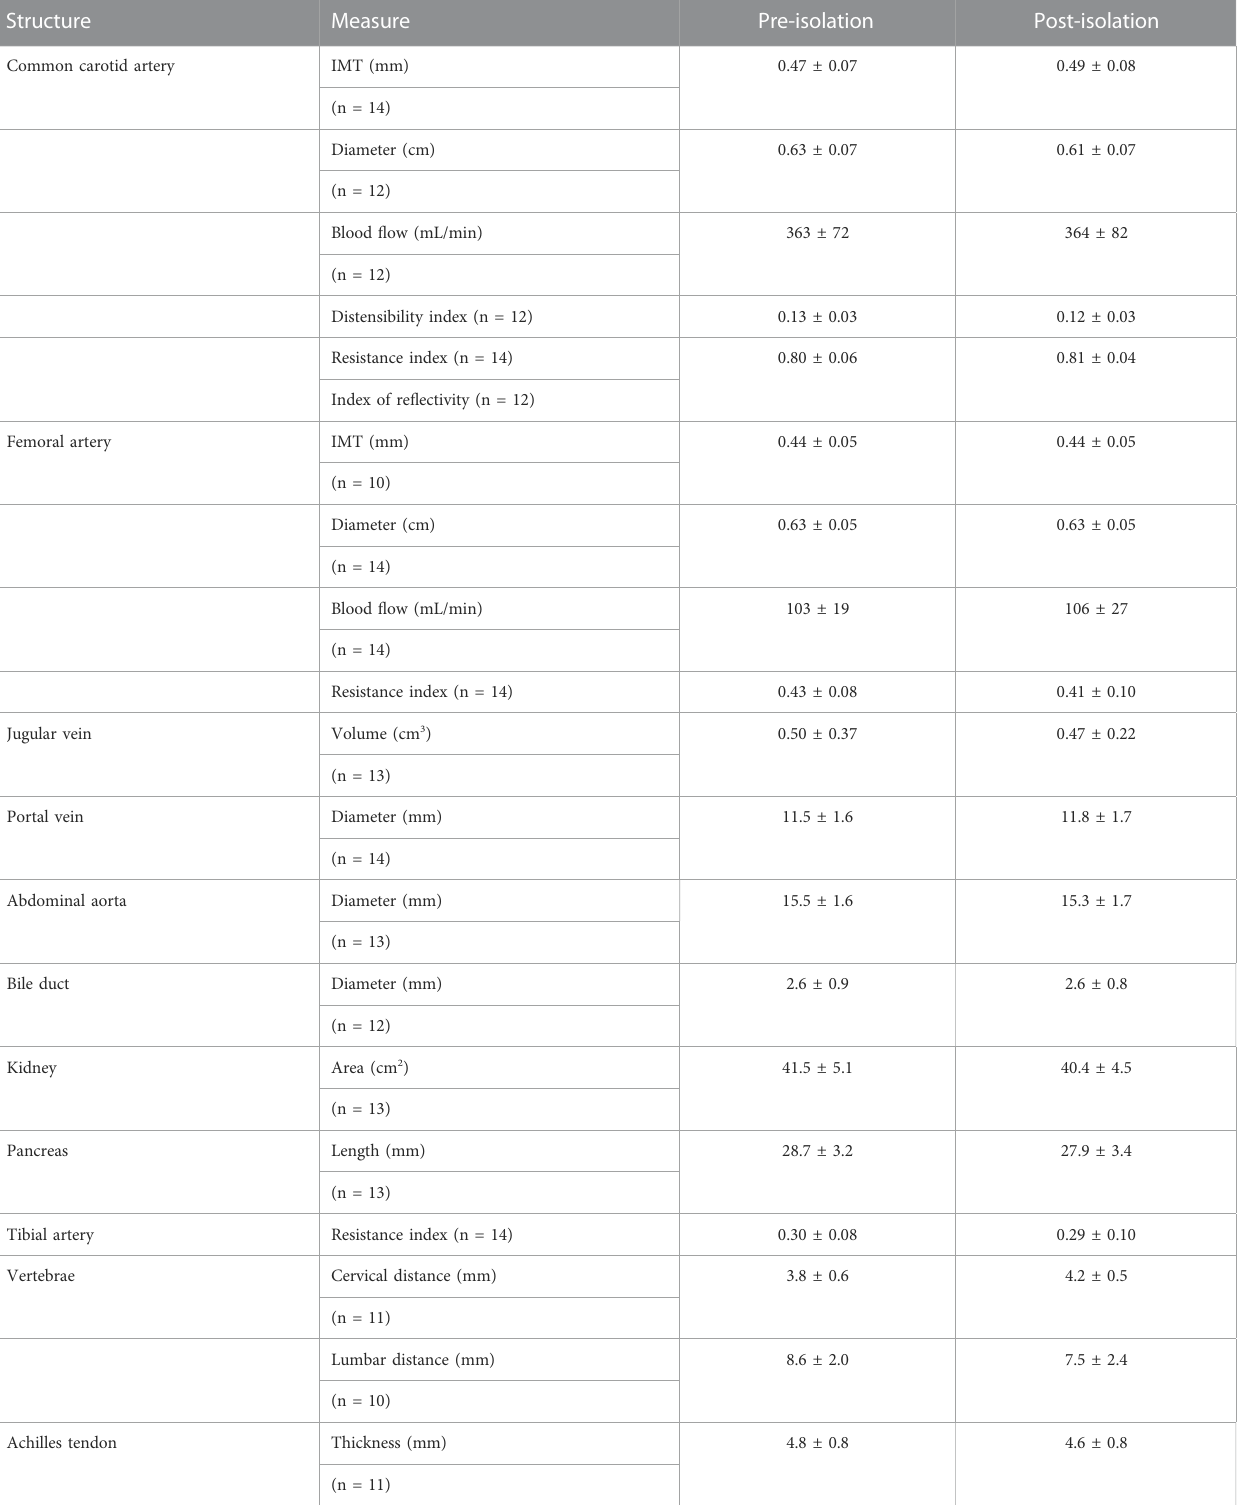
TABLE 1 Ultrasound measurements before and after 40 days of